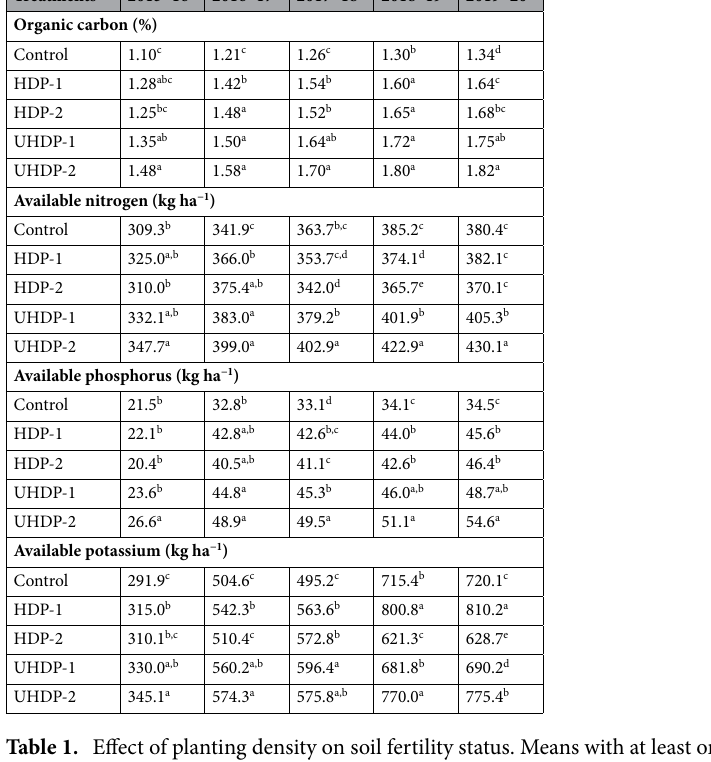
Table 1. Effect of planting density on soil fertility status. Means with at least one letter common are not statistically significant using TUKEY’s Honest Significant Difference at 5% Control: Planting at 6 m (row to row) × 6 m (plant to plant) spacing (tree density—277 plants ha −1 ), HDP-1: Planting at 6 m (row to row) × 3 m (plant to plant) spacing (tree density—555 plants ha −1 ), HDP-2: Planting at 4 m (row to row) × 4 m (plant to plant) spacing (tree density—625 plants ha −1 ), UHDP-1: Planting at 4 m (row to row) × 2 m (plant to plant) spacing (tree density—1250 plants ha −1 ), UHDP-2: Planting at 2 m (row to row) × 2 m (plant to plant) spacing (tree density—2500 plants ha −1